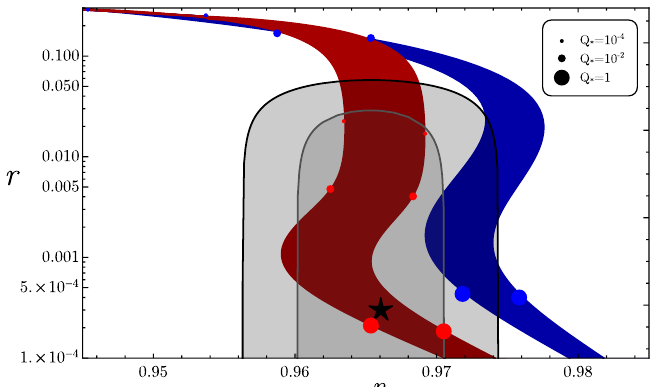
Figure 2 . Inflationary spectrum ( n s , r ) for V ( φ ) = λφ 4 as a function of Q ∗ , with the r axis in log -scale. The red (blue) shaded region corresponds to the case where the inflaton fluctuations have a nearly-thermal (negligible) spectrum at horizon crossing. The left (right) contour of these regions correspond to a N e = 50 ( 60 ) of inflation. As Q ∗ → 0 , both regions converge to a straight line encompassing the predictions of cold inflation, ( n s , r ) ∈ (0 . 94 − 0 . 95 , 0 . 32 − 0 . 27) for N e = 50 − 60 . The black star represents the case of figure 1. The black (gray) contour signals the 95% ( 68% ) confidence limit of [71] for the TT,TE,EE+lowE+lensing +BK14+BAO